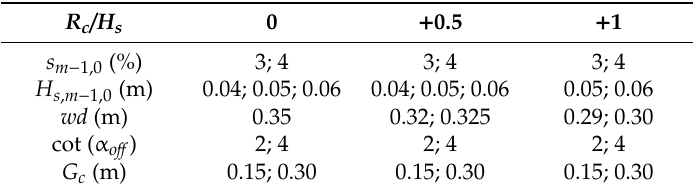
Table 1. Summary of the target conditions of the experiments of wave overtopping at dikes.